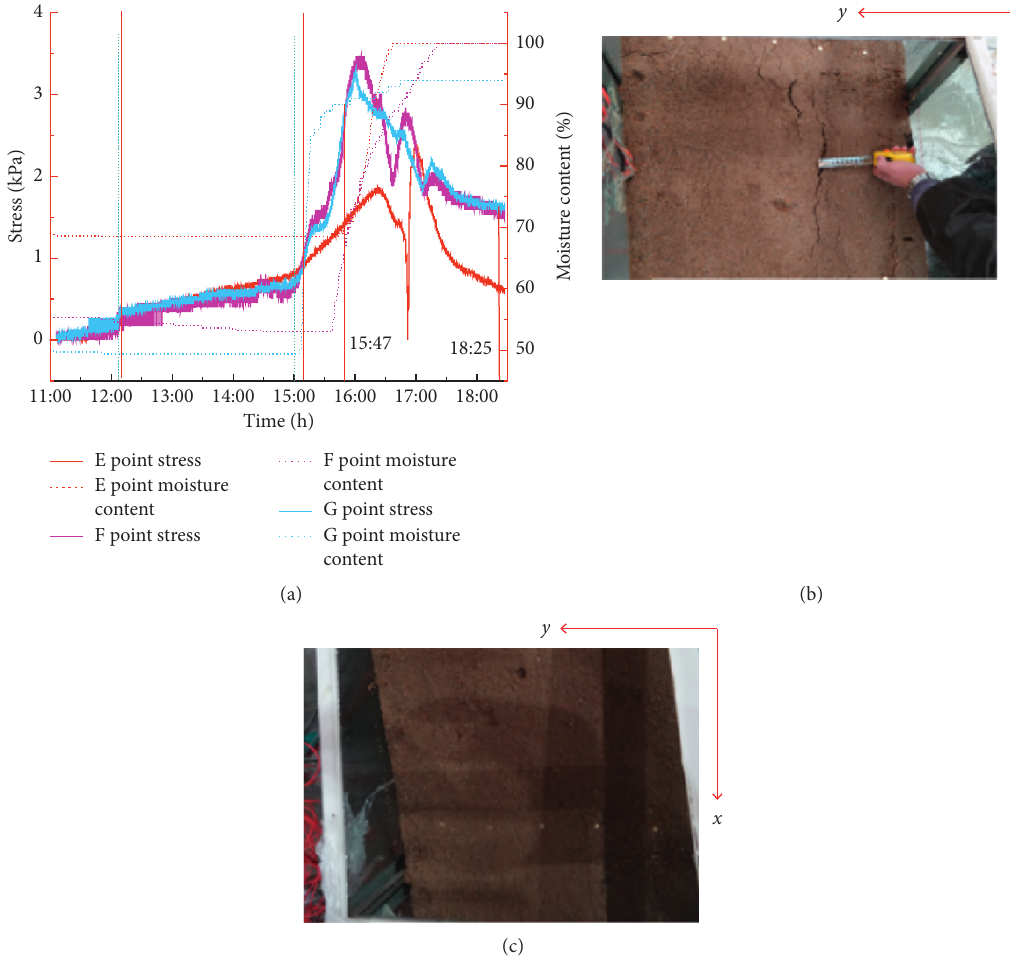
Figure 17: Stress-moisture content time history curve of vertical sections E, F, G in